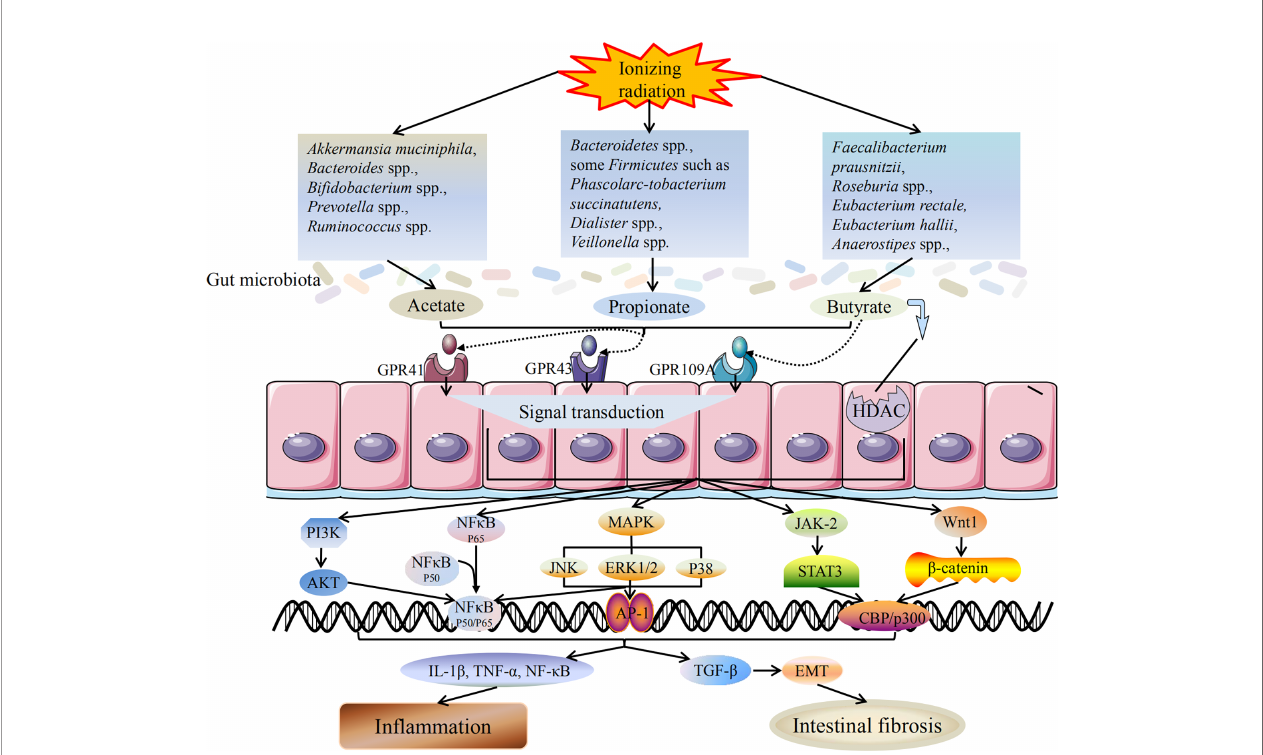
FIGURE 1 | Mechanism of SCFAs on radiation-induced intestinal injury. Radiotherapy can lead to dysbiosis of the gut microbiota, including the changes in SCFAs- producing bacteria. The bacteria producing acetate, propionate and butyrate are all reduced, and the ability to produce SCFAs is weakened accordingly. SCFAs mainly induce downstream reactions through two pathways: activation of GPCRs and inhibition of HDAC. After activating GPCRs, SCFAs can act on downstream MAPK, NF- k B, PI3K/AKT, JAK/STAT, Wnt/ b -catenin and other signaling pathways to promote signal transduction. SCFAs production is reduced and its anti- in fl ammatory activity is weakened, which in turn promotes the release of in fl ammatory cytokines and triggers in fl ammatory response. In addition, reduced production of SCFAs also induces TGF- b mediated intestinal fi brosis. In fl ammation and intestinal fi brosis are two different outcomes of acute and chronic radiation-induced intestinal injury. Black arrows indicate promotion, and black lines indicate